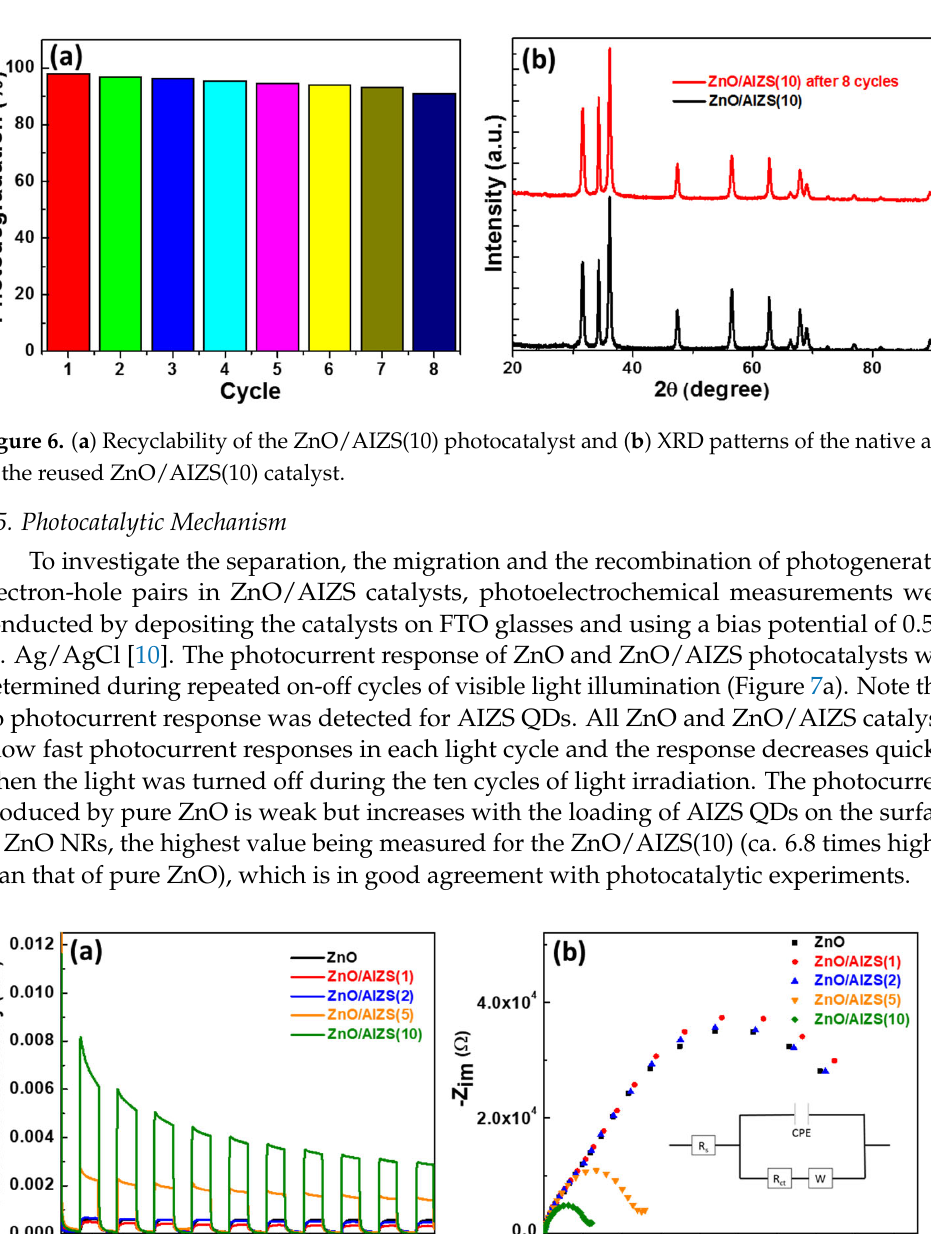
7 of 14 Figure 5. ( a ) Photocatalytic degradation kinetics of OA7 aqueous solution using AIZS QDs, ZnO NRs and ZnO/AIZS heterostructured photocatalysts and ( b ) evolution of UV ‐ visible absorption spectra of AO7 during the photodegradation using the ZnO/AIZS(10) catalyst (the inset of b is a photograph of aliquots taken during the photodegradation). The photodegradation kinetics were determined using the pseudo ‐ first ‐ order model ln(C 0 /C t ) = kt, where C 0 and C t are the initial concentration and after a time t of OA7, and k is the kinetic constant. The k values determined for AIZS QDs, ZnO NRs, ZnO/AIZS(1), ZnO/AIZS(2), ZnO/AIZS(5) and ZnO/AIZS(10) composites are 0.61 x 1 0 − 3 , 1.17 x 10 − 3 , 0.26 x 10 − 3 , 1.40 x 10 − 3 , 5.99 x 10 − 3 and 36.27 x 10 − 3 min − 1 , respectively, and confirm that the ZnO/AIZS(10) catalyst displays the highest activity (Figure S2). 2.4. Reuse and Stability of the Photocatalyst